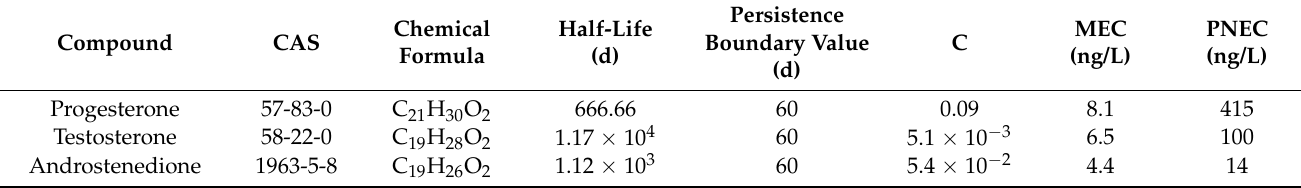
Table 3. Basic data of endocrine disruptors in surface water of Xiangjiang River,